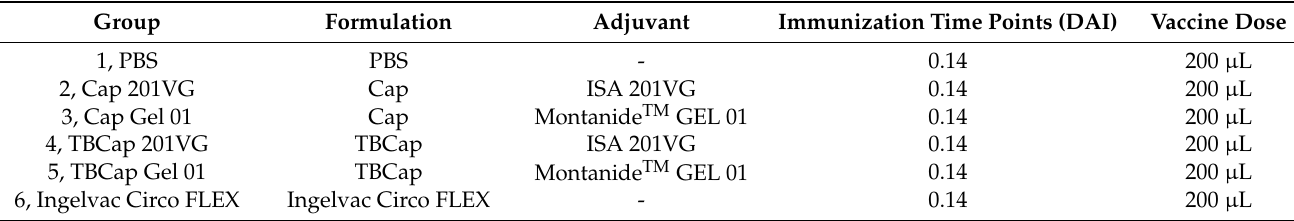
Table 2. Mouse vaccination